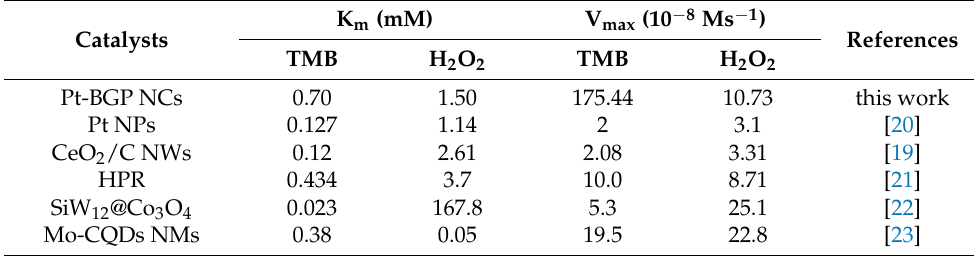
Figure 5. The catalytic kinetics of Pt-BGP NCs for ( a ) TMB and ( b ) H 2 O 2 ; ( c , d ) was the reciprocal of ( a , b ). Table 1. Comparison of kinetic parameters of K m and V max .